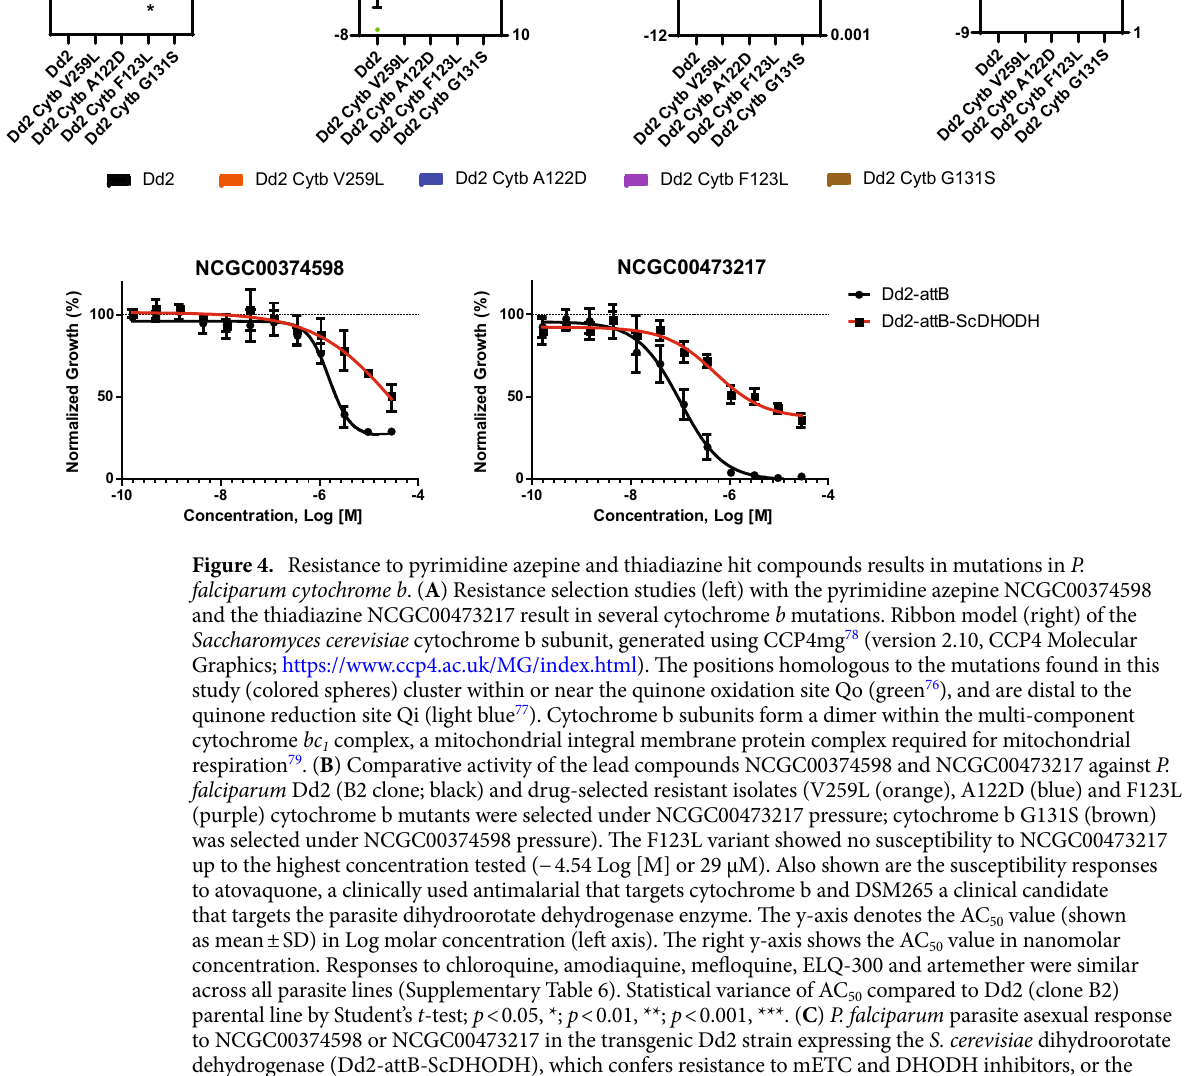
dehydrogenase (Dd2-attB-ScDHODH), which confers resistance to mETC and DHODH inhibitors, or the